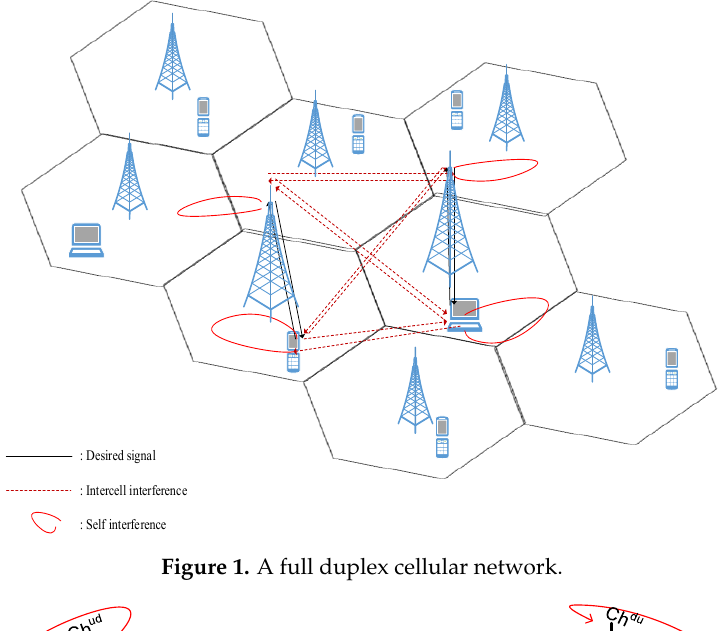
Figure 1. A full duplex cellular network.